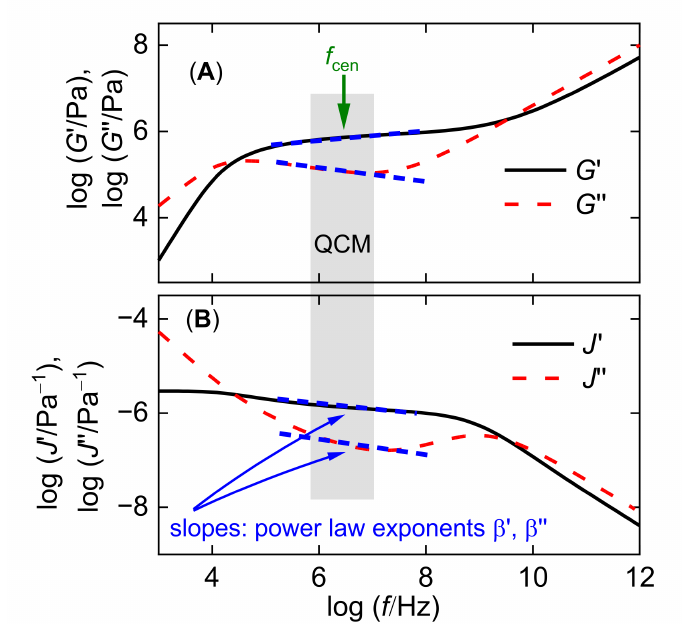
Figure 3. The shear moduli of viscoelastic materials depend on frequency. The plot shows a typical rheological spectrum of a solution of a long-chain linear polymer. The frequency scale extends over many decades, while the QCM only covers about one decade. In this limited frequency range, G (cid:48) ( f ) and G ”( f ) can be approximated by power laws (dashed blue lines) in panel A. For the QCM, the representation with { J (cid:48) ( f ), J ”( f )} in panel B is more practical than the set { G (cid:48) ( f ), G ”( f )}. The graph discusses viscoelasticity in terms of either { G (cid:48) , G (cid:48)(cid:48) } or { J (cid:48) , J ”}. The same arguments apply to—for instance—the pair {| (cid:101) G |, tan δ } (see Equation